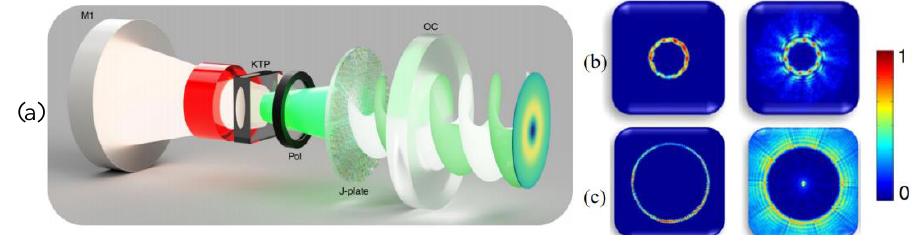
Figure 19. ( a ) Schematic of the resonator using a metasurface (J-plate); ( b , c ) represent the output laser modes modulated with intra-cavity and external cavity approaches when the topological charge l = 10, 100, respectively (Adapted from an open-access source Ref. [117]).